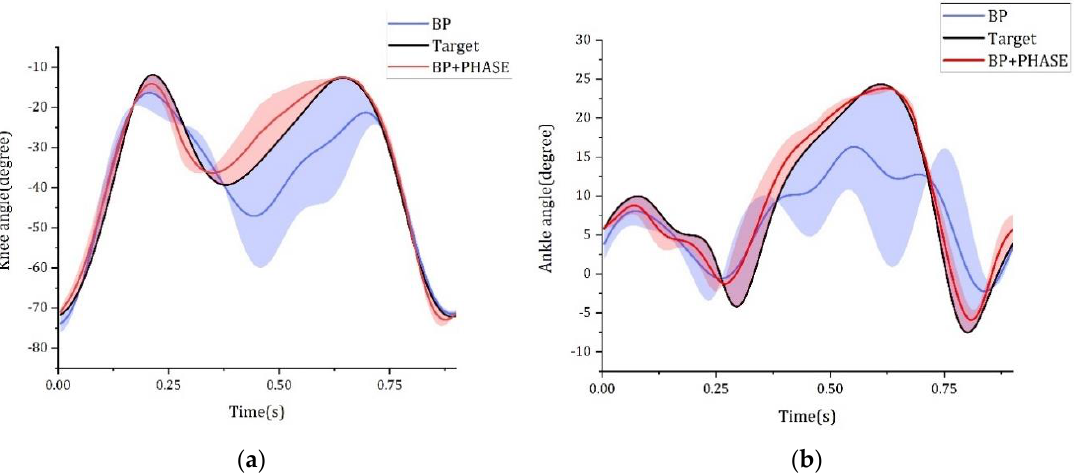
Figure 5. ( a ) represents the results of subject AB14 and knee angle. ( b ) represents the results of AB14 and ankle angle. The shaded area shows the error. and ankle angle. The shaded area shows the error.